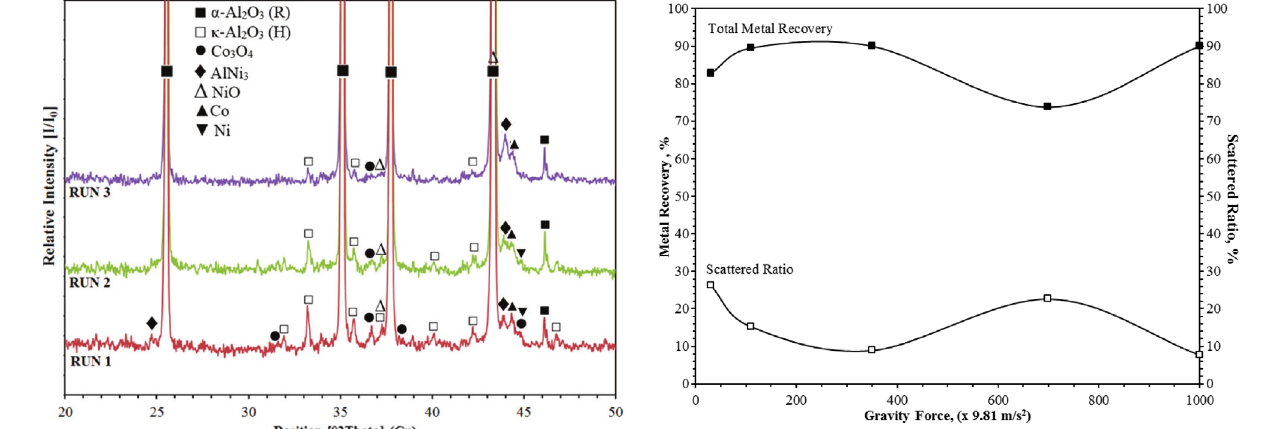
Fig. 5: The comparative XRD results of slags obtained by 20% Al 2 O 3 addition to batch type SHS reactions under normal gravity conditions